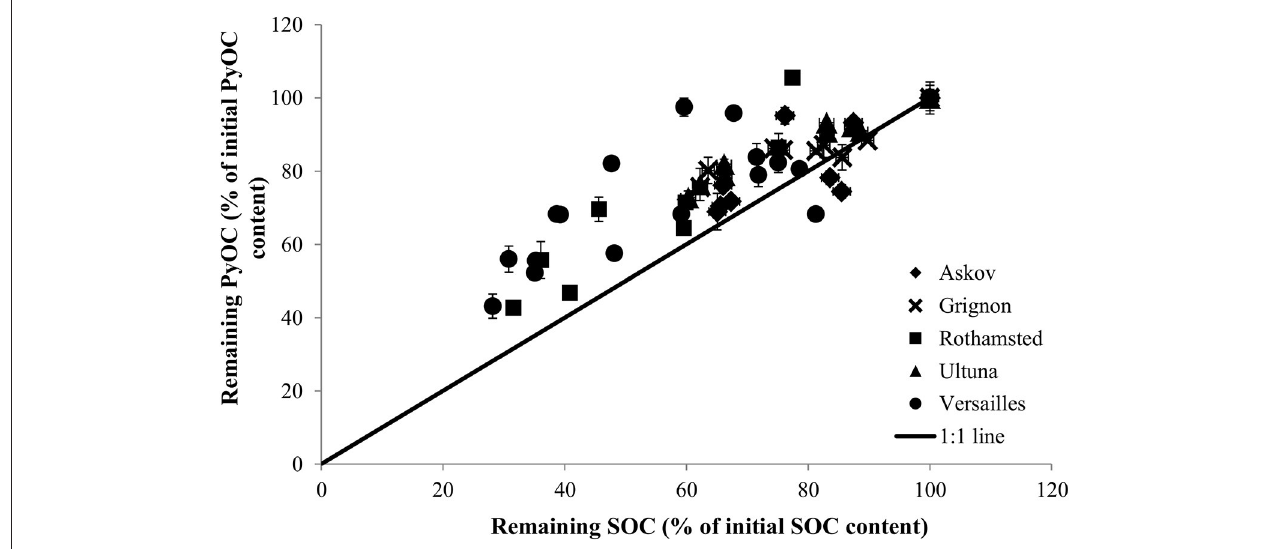
FIGURE 4 | PyOC losses occur more slowly than SOC losses (1:1 line), far from the concept of PyOC being inert (0:1 line). Values are expressed as % of initial SOC and PyOC contents. Time series start at the 100% values for both PyOC and SOC, vertical error bars represent PyOC variability within analytical replicates ( < 10%), horizontal error bars represent analytical errors on SOC measurements ( < 3%). The average annual loss of SOC ranged from 0.7% at Ultuna to 1.4% at Rothamsted while losses of PyOC varied from 0.4% at Versailles to 1.2% at